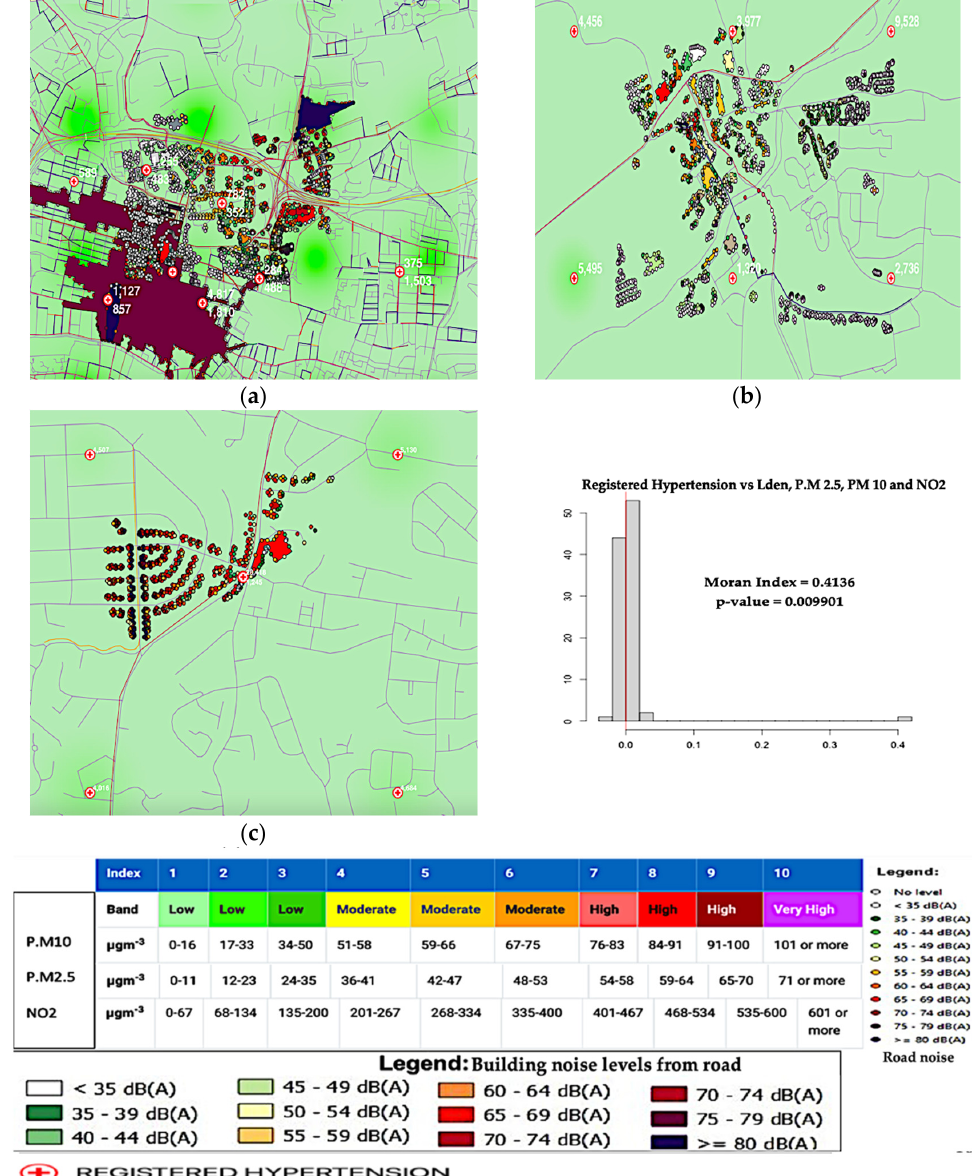
Figure 1. Joint annual average NO 2 , PM 10 , and PM 2.5 concentrations ( μ g/m 3 ) and noise level (Lden) at five monitoring locations (23 November 2021): ( a ) joint air–noise pollution and hypertension at GK, GT, and GHS; ( b ) joint air–noise pollution and hypertension at EDK; and ( c ) joint air–noise pollution and hypertension at EDB.